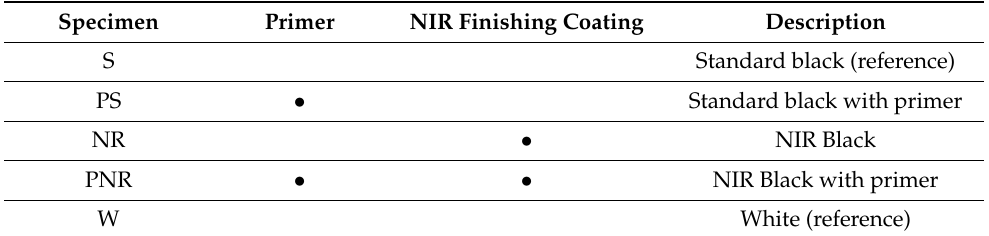
Table 1. Constitution of the specimens.